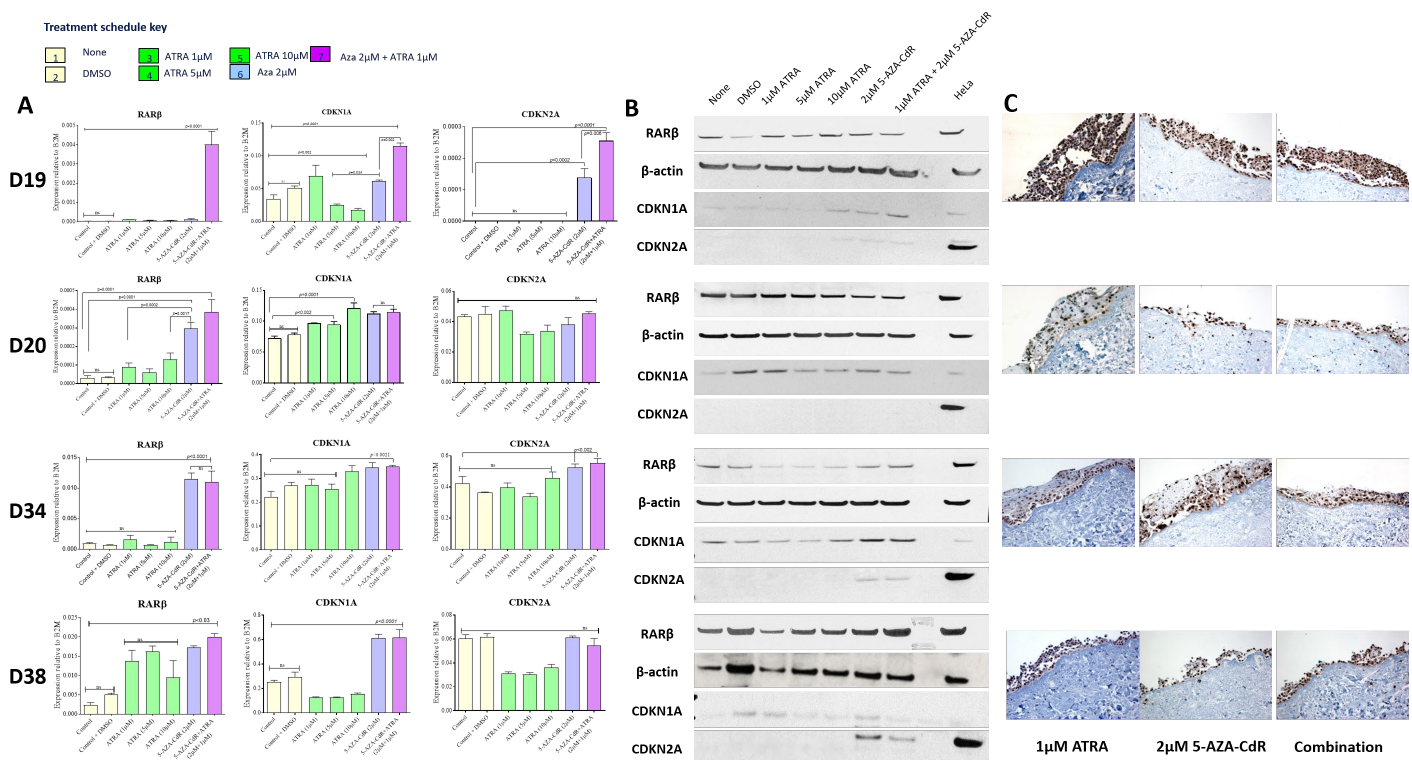
Figure 3. Expression of RAR β and cell cycle markers in iPMOL cells when treated with varying concentrations of ATRA and 5-AZA-CdR used either alone or in combination. ( A ) Expression RAR β 2, CDKN1A, and CDKN2A was assessed by qPCR in D19, D20, D34, and D38 cells after treatment with varying doses of ATRA, 5-AZA-CdR alone, or a combination of 5-AZA-CdR and ATRA. Increased expression of RAR β was noted in D19, D20, and D34 ( p < 0.0001) when treated with a combination of 5-AZA-CdR and ATRA or 5-AZA-CdR alone. A concomitant increase in expression of CDKN1A and CDKN2A was observed in D19 and D38 ( p < 0.002). D38 showed an increase in the CDKN1A expression proportionate to the re-expression of RAR β on treatment with ATRA and a combination of 5-AZA-CdR and ATRA ( p < 0.0001). Repeated-measures one-way ANOVA with post hoc Tukey’s test was performed to determine the statistical significance ( p < 0.05). M = methylated; UM = unmethylated. ( B ) Western blotting for RAR β , CDKN1A, and CDKN2A upon treatment with the varying concentrations of ATRA and 5-AZA-CdR or in combination confirmed their re-expression in the iPMOL cells. M = methylated; U = unmethylated. ( C ) Expression of RAR β was assessed in 3D TEMs constructed using each of the iPMOL cells by immunohistochemistry. The matched untreated TEMs are shown in Figure 1E. Total RAR β staining of the untreated and treated cells with ATRA showed a significant difference in 3D tissue-engineered oral mucosal models before and after treatment. The models were insufficiently robust to withstand the combination of ATRA and